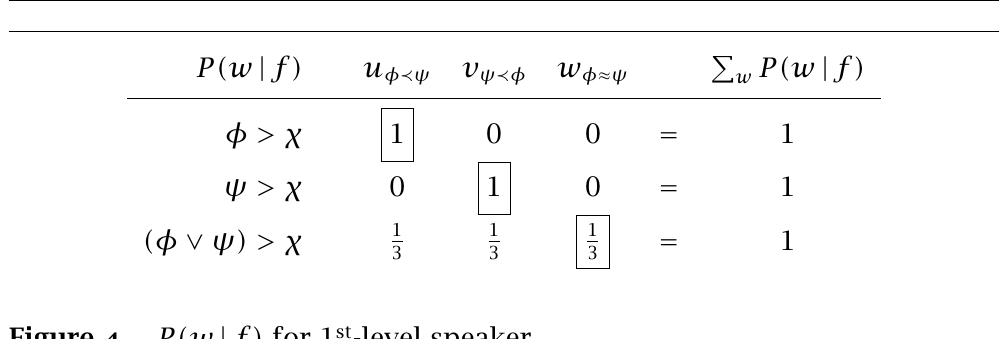
Figure 4 P(w | f ) for 1 st -level speaker chooses (one of) the highest rows in the columns. In u would choose as before, but in w of either of the others. This is again represented by boxed entries in figure 4